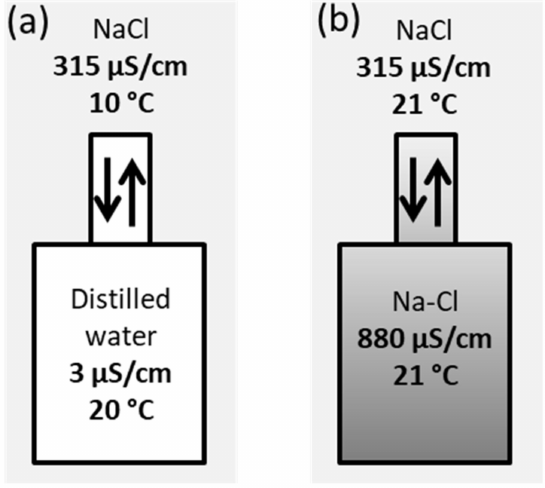
Figure 3. Laboratory re–equilibration tests for passive liquid samplers ( a ) sampler filled with distilled water, as used in situ, ( b ) sampler containing a solution more saline but similar temperature than its environment to only study molecular